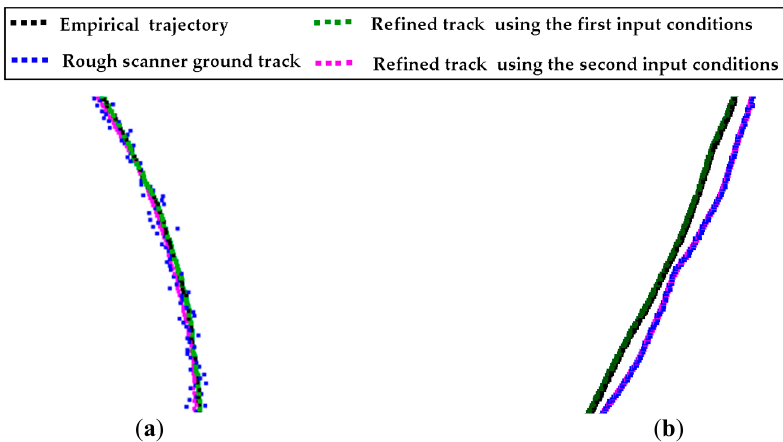
Figure 14. The refined ground trajectory of scanner obtained using different methods under two kinds of input conditions. ( a ) Data 3. ( b ) Data 2.